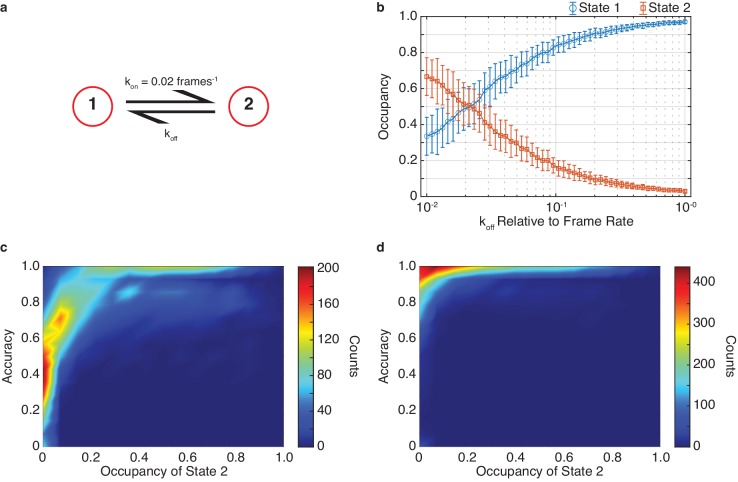
The effect of state occupancy on DISC.(a) Simulated kinetic scheme of Figure 2 featuring two states with a constant kon (kon = 0.02 frames−1) and varying koff. (b) Occupancy of state 1 (blue circles) and state 2 (orange squares) for different simulated koff values (mean ± s.d.). (c, d) Density plot of idealization accuracy per trajectory vs the occupancy of state two across all simulations (N = 5000) for results obtained without (c) and with Viterbi refinement (d).